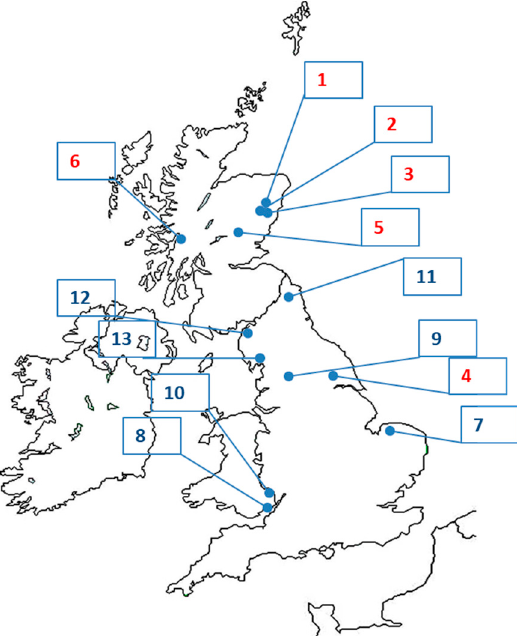
Figure 1. The locations of biocide treatments against signal crayfish in the U.K. (projects 1–6, see Table